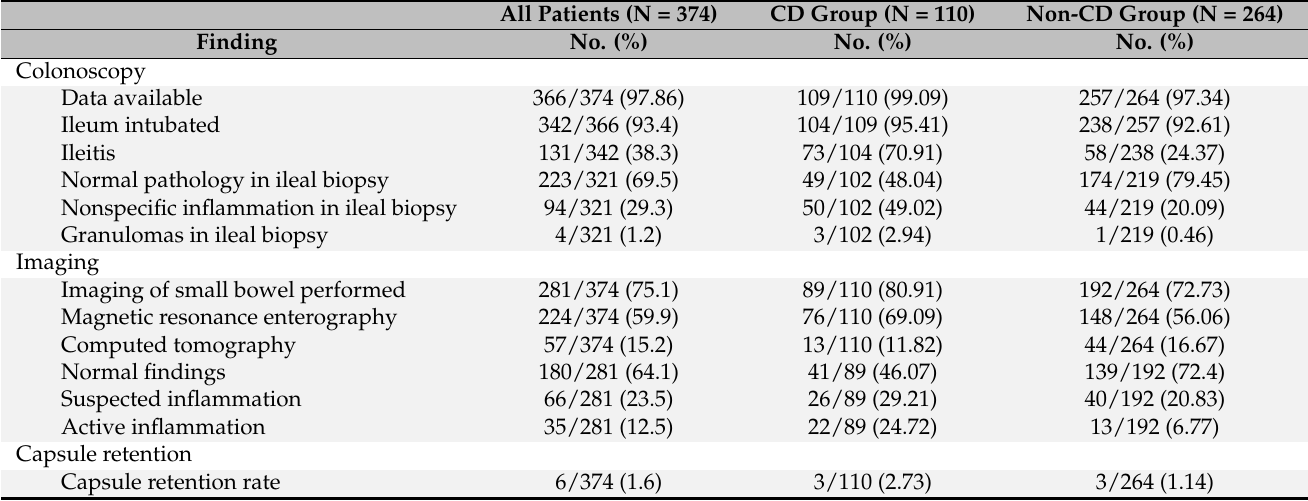
Table 2. Endoscopic, imaging and biopsy findings and capsule retention rate by